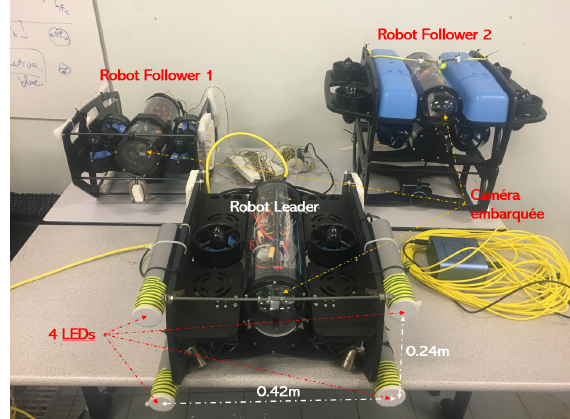
Figure 7. Three l-UD BlueROVs for experimentation.